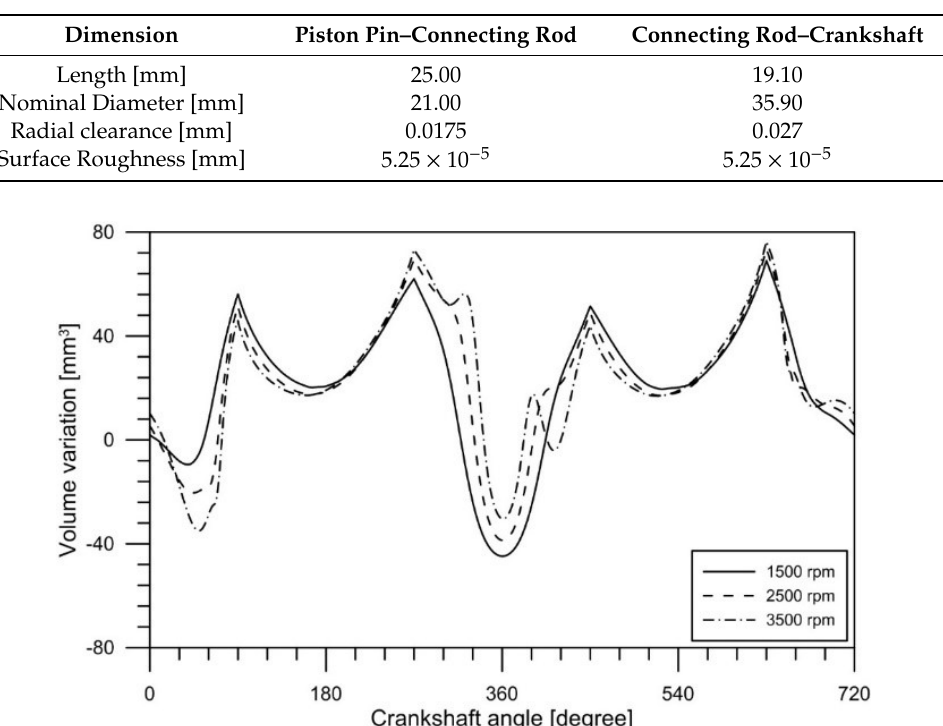
Figure 13. Volume variation due to clearance for regimens studied.